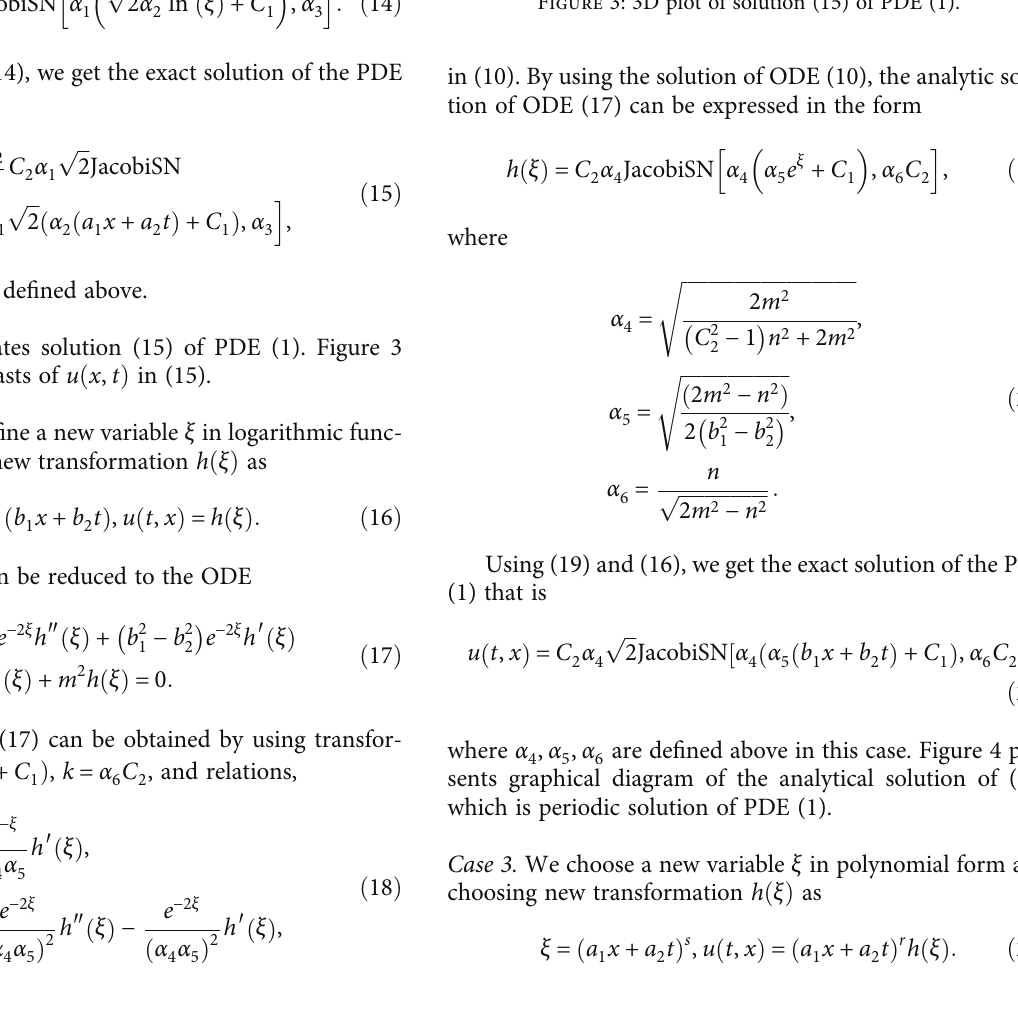
Figure 3: 3D plot of solution (15) of PDE